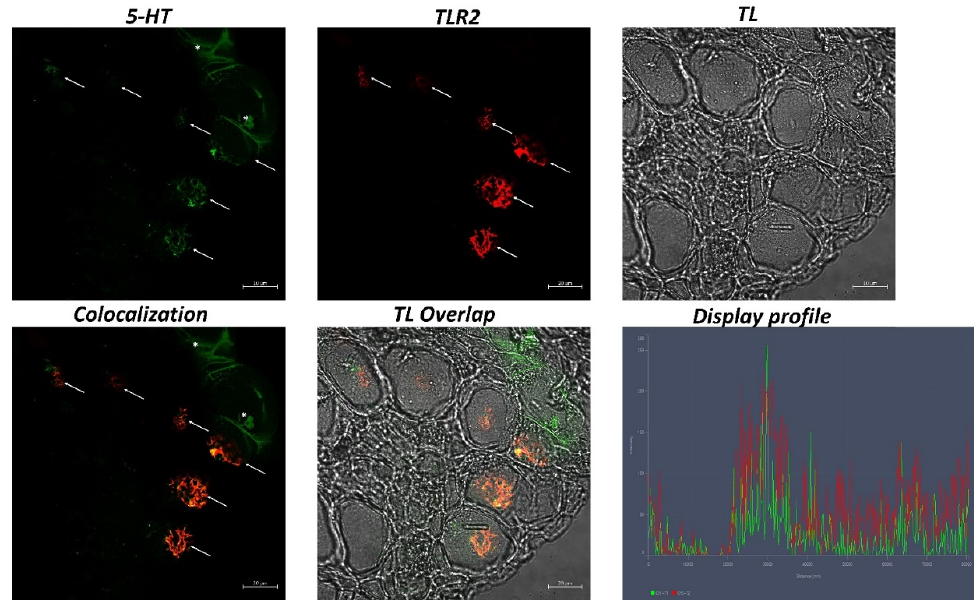
Figure 2. Immunofluorescence of 5-HT and TLR2 in the intestine of hagfish, 40×, scale bar 20 nm. Immunopositivity of goblet cells to 5-HT (green) and TLR2 (red) is evident (arrows). In addition, some neuroendocrine cells are highlighted with 5-HT (*). The colocalization of the two antibodies is confirmed by the “display profile” function. TL = transmitted light.